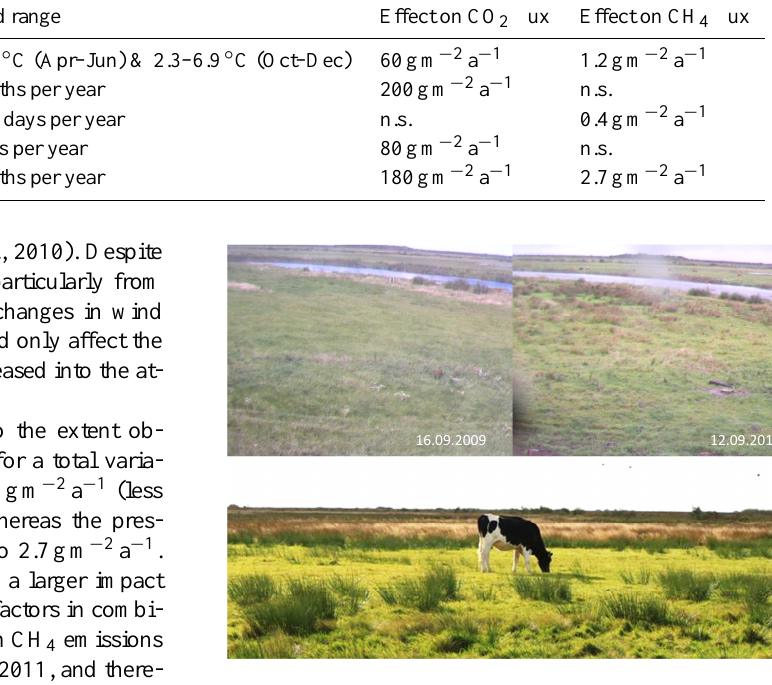
Fig. 7. Grazing cattle on Skjern Meadows promote the spreading of soft rush plants, which enable methane to bypass the aerated top soil through their aerenchyma. The upper photos show the view from the instrument mast towards the meadows in late summer, first in an undisturbed status (2009) and then after a long grazing pe- riod (2010). The lower photo illustrates that the soft rush plants are spared by the